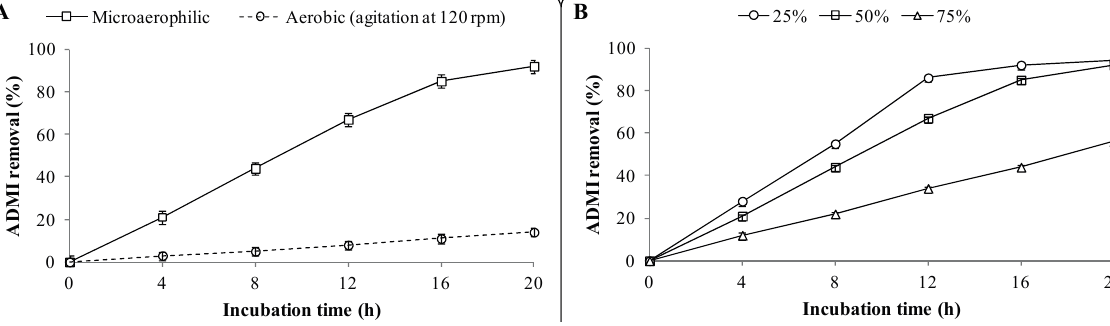
Figure 4. Batch studies on decolorization of RTE by PUF-immobilized microbial consortium at 30 ± 0.2 °C. ( A ) Microaerophilic and aerobic incubation; and ( B ) different RTE concentrations v.z. 25%, 50% and 75%. Decolorization was measured in terms of percent ADMI removal. Data points indicate the mean of three independent replicates; ±SEM is indicated by error